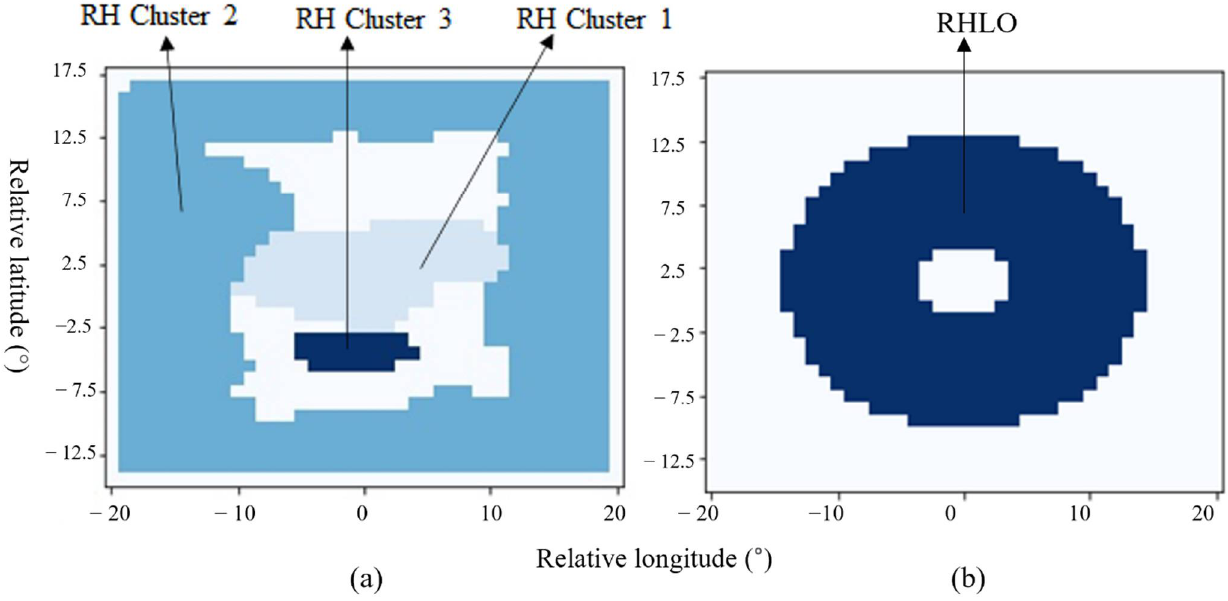
Figure 7. ( a ) Three SNN clusters of 850–700 hPa relative humidity that are significantly different in RI and non-RI groups, and ( b ) RHLO in SHIPS database. RI and non-RI groups, and ( b ) RHLO in SHIPS